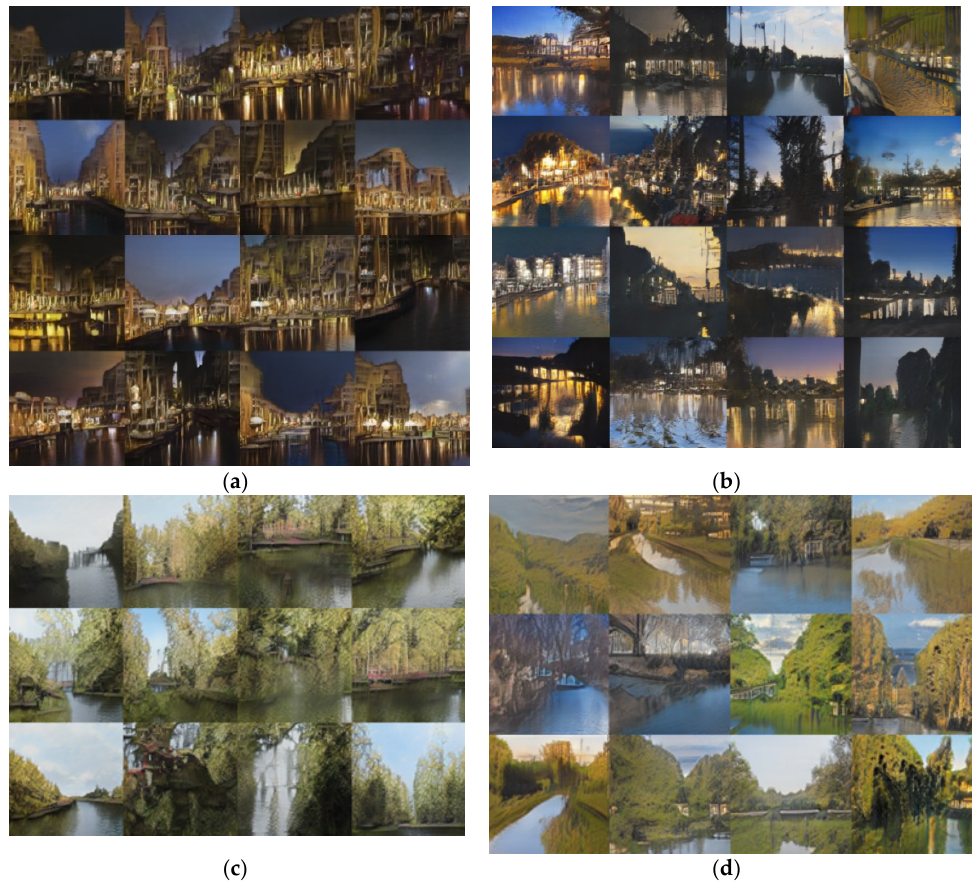
Figure 6. Images Generated by Different Methods. ( a ) “canal at night” by AttnGAN, ( b ) “canal at night” by the proposed method, ( c ) “canal in autumn”by AttnGAN, ( d ) “canal in autumn”by the proposed method.